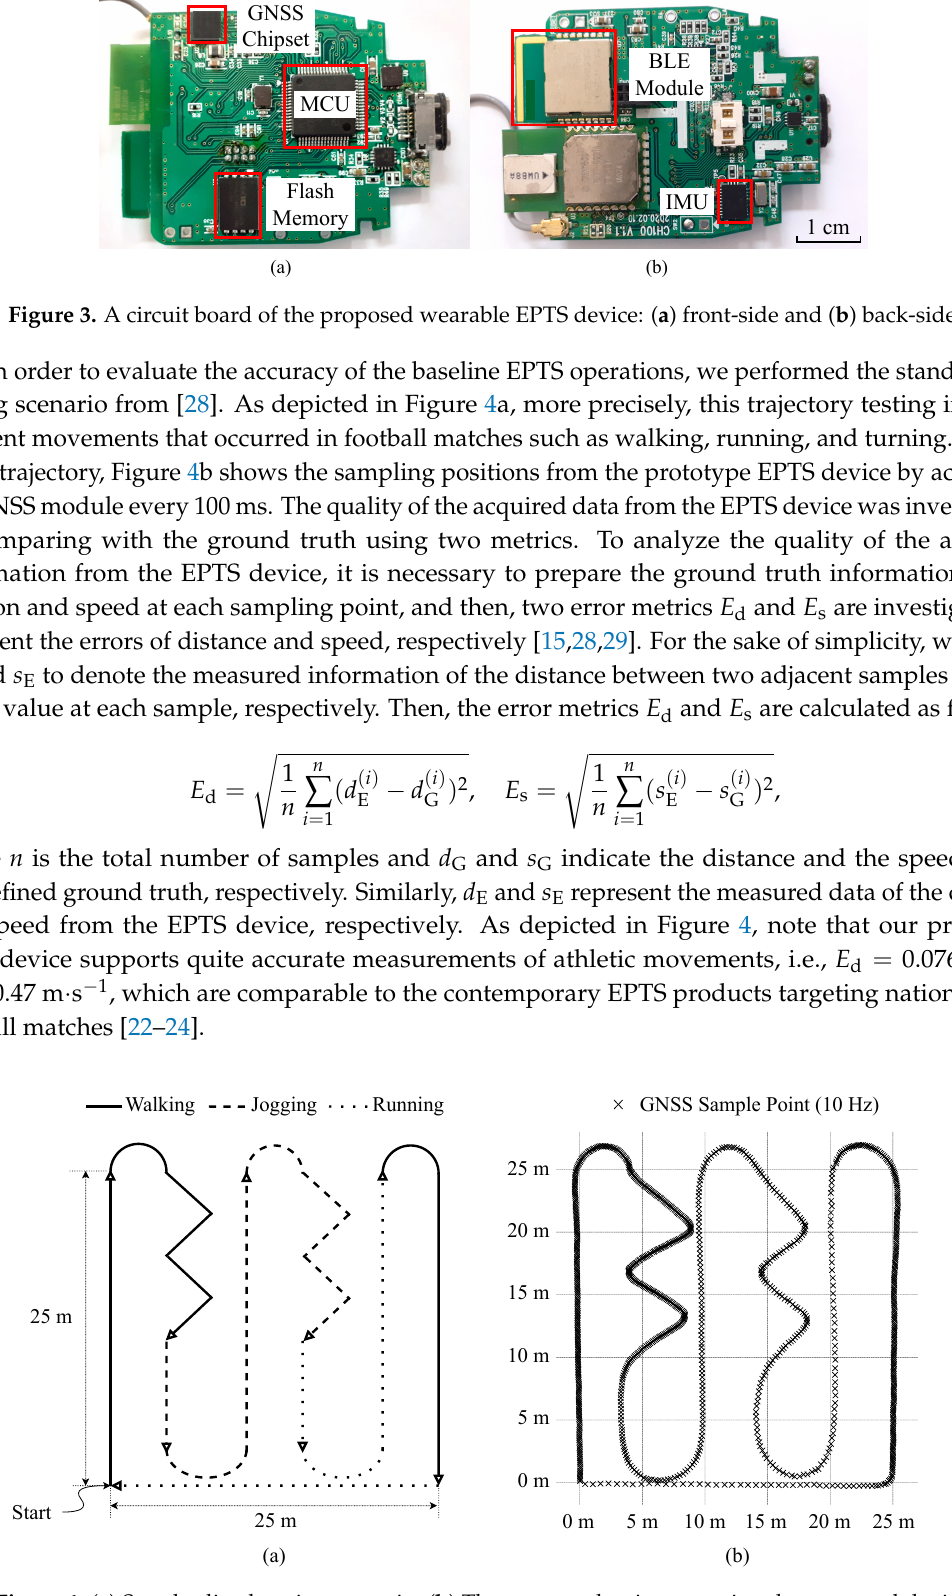
Figure 4. ( a ) Standardized testing scenario. ( b ) The measured trajectory using the proposed